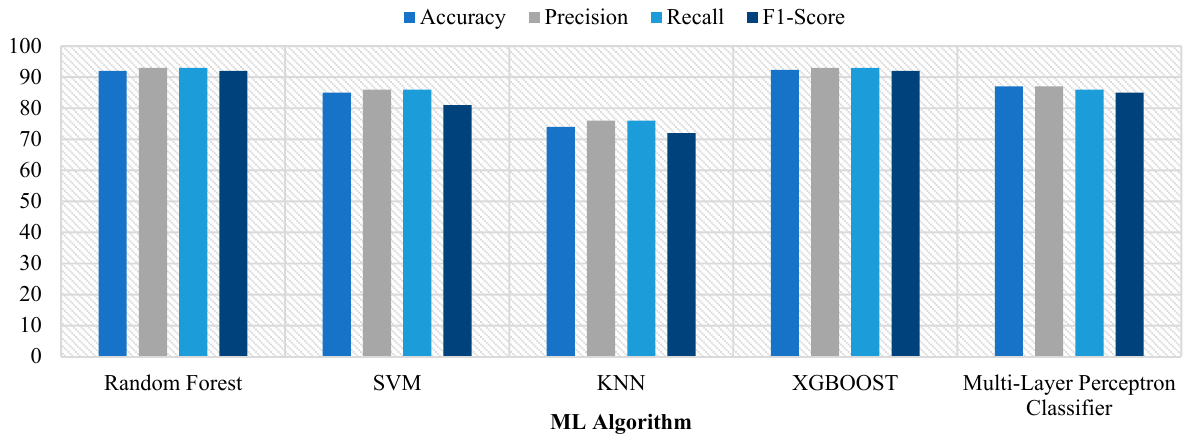
Figure 5. Performance of algorithms used to model natural gas pipeline.